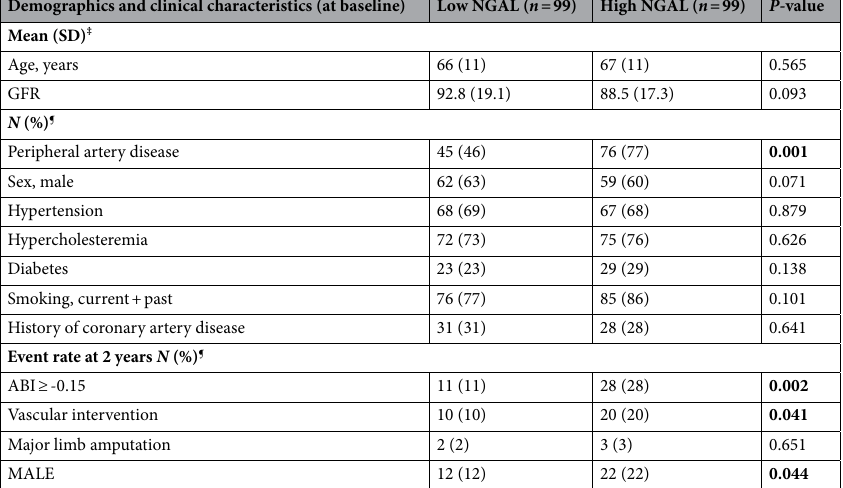
Table 3. Baseline patient demographics and clinical characteristics of the Low NGAL and High NGAL study subgroups. Low NGAL group ( n = 99): NGAL ≤ 48.7 μg/g. High NGAL group ( n = 99): NGAL > 48.7 μg/g. eGFR: estimated Glomerular Filtration Rate. ‡ Compared using student’s t-test. ¶ Compared using chi-square test. ABI: Ankle Brachial Index; MALE—defined as vascular intervention or limb loss. Significant values are in bold.